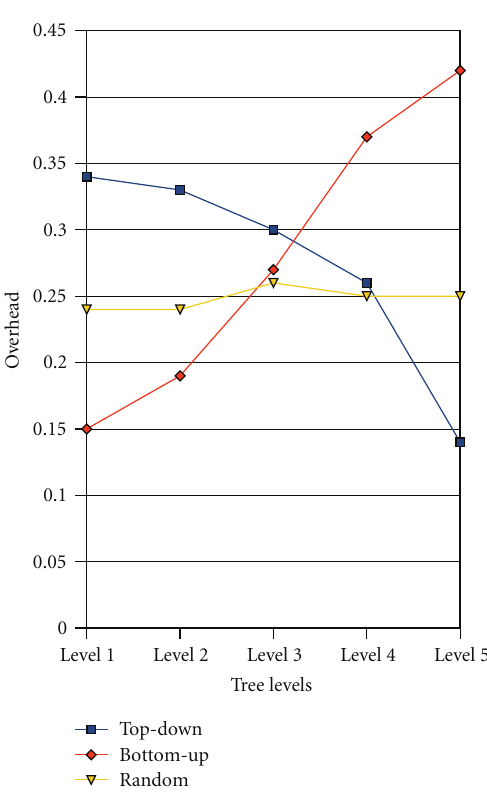
Figure 6: Overhead between Architecture and partitioned netlist Rent’s parameters (21 benchmark average).